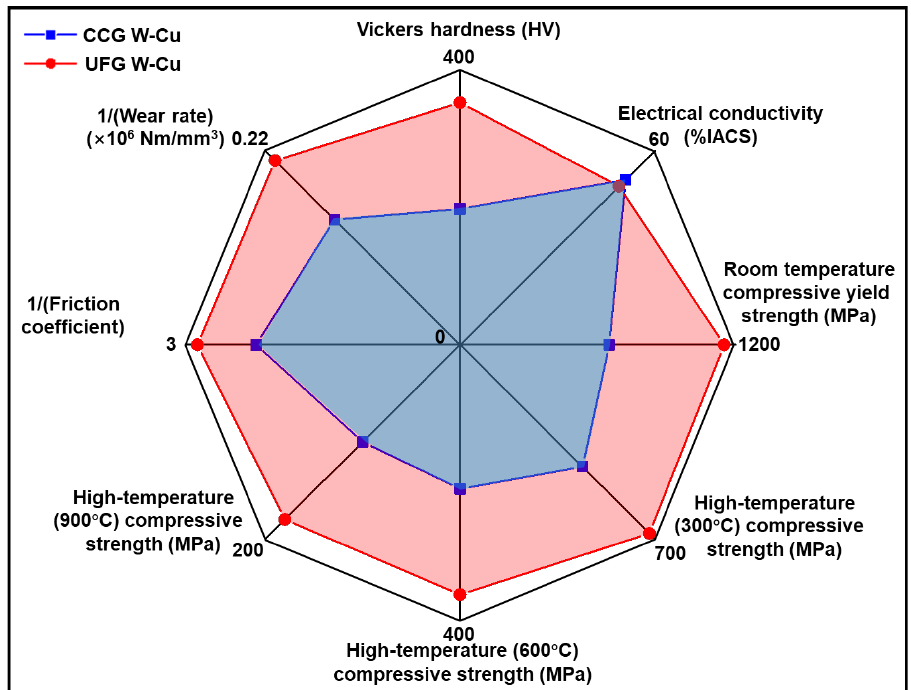
Figure 9. Comparison of the overall properties of the UFG W – Cu and the CCG W – Cu composites, indicating that the UFG W – Cu exhibits superior comprehensive performance.